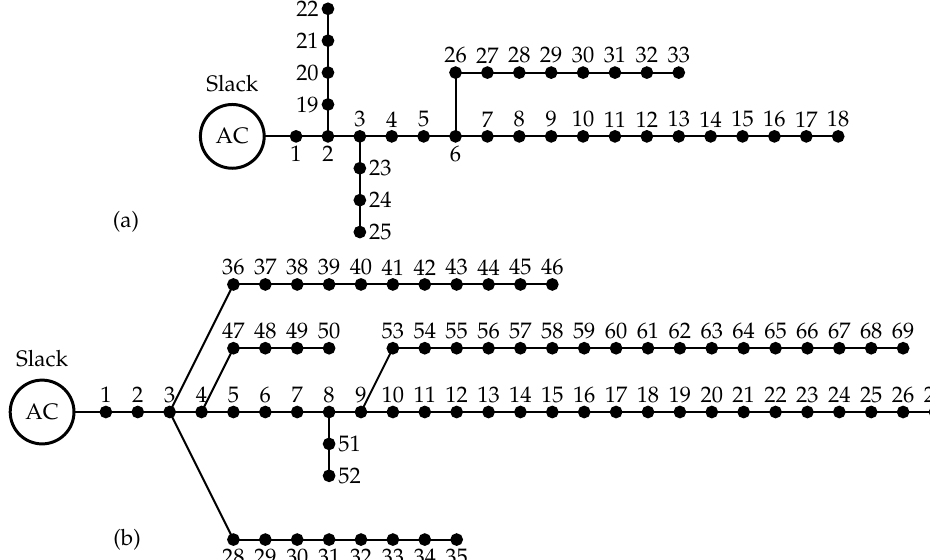
Figure 3. Electrical configuration of the test systems: ( a ) IEEE 33-bus system and ( b ) IEEE 69-bus